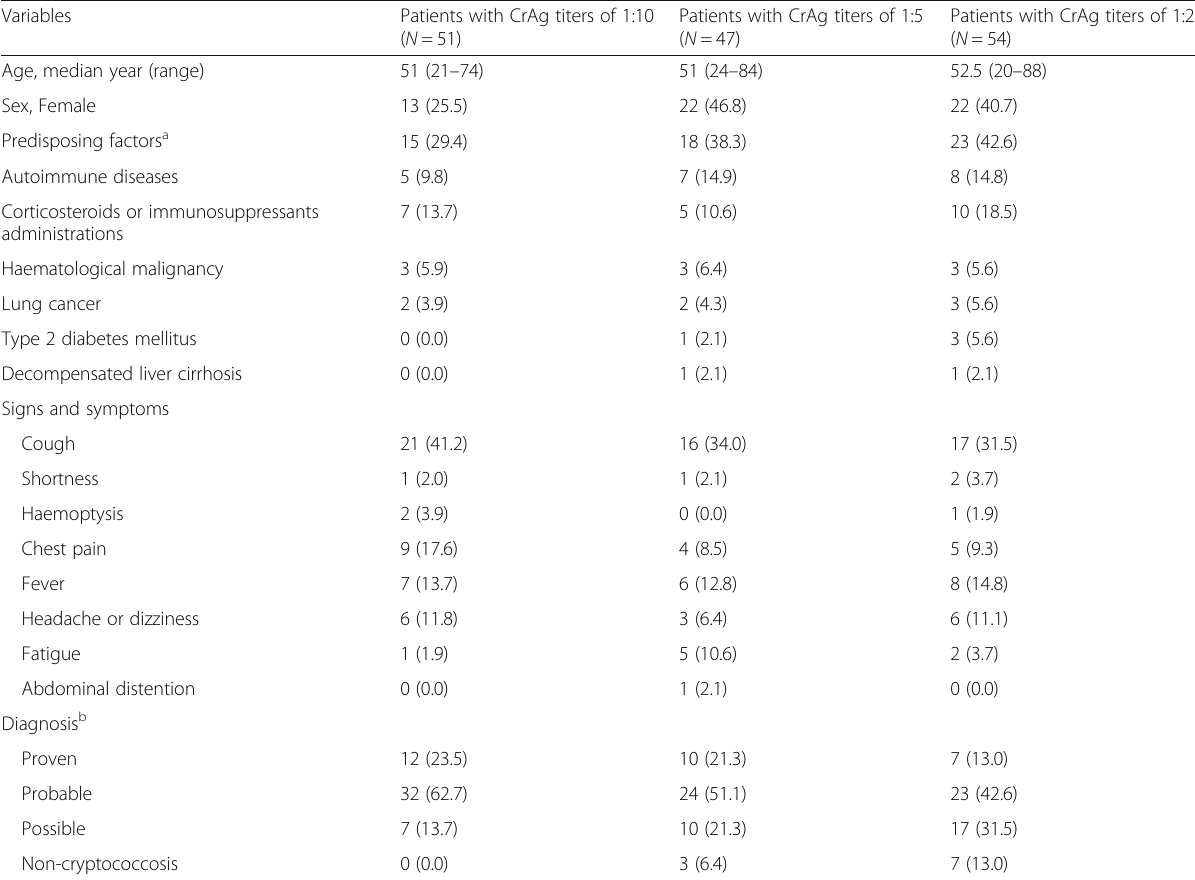
Table 1 Basic characteristics of patients with low CrAg LFA results Variables Patients with CrAg titers of 1:10